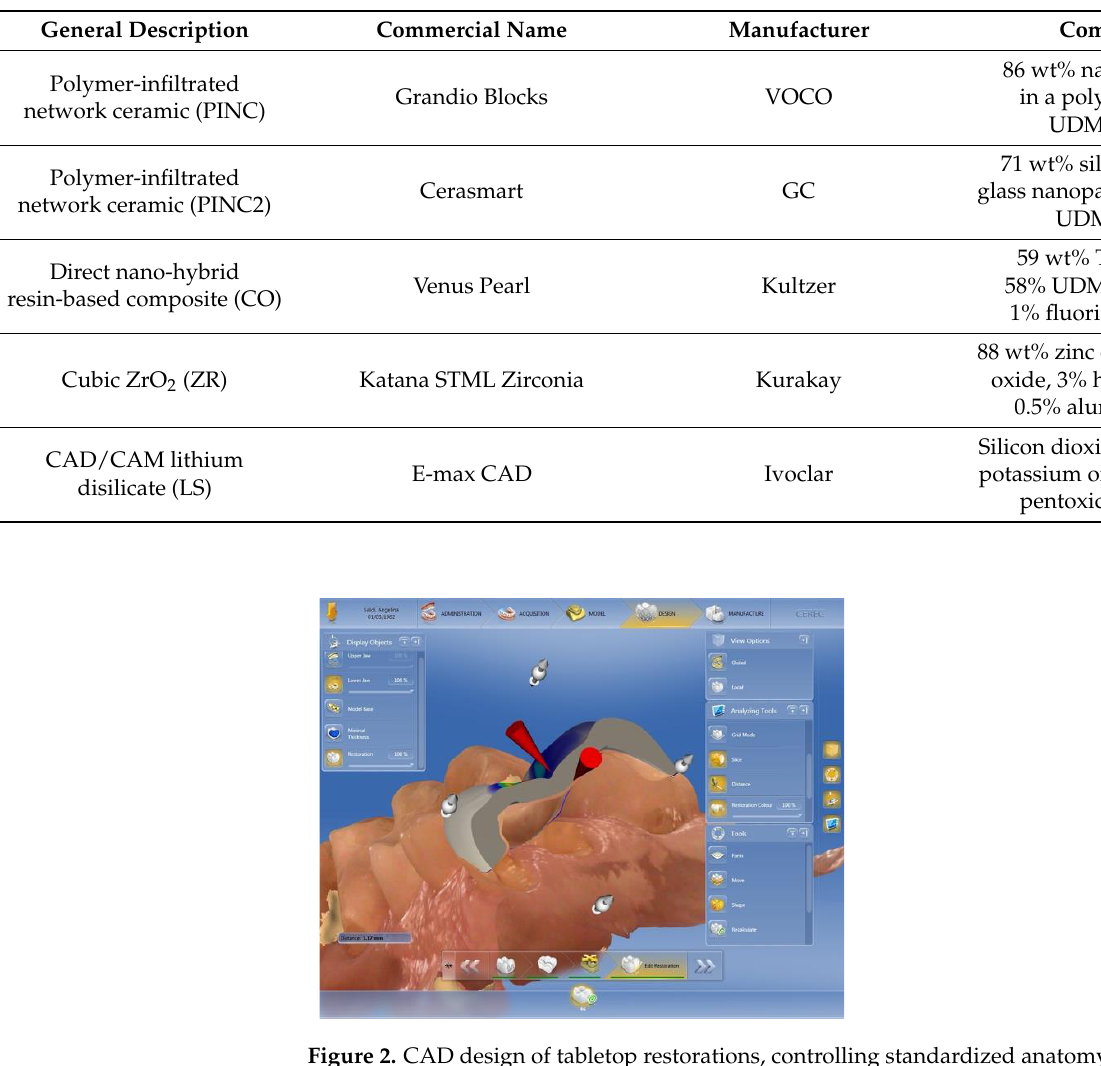
Table 1. General description of the main materials used in the present study, along with their com- mercial name, manufacturer and composition.